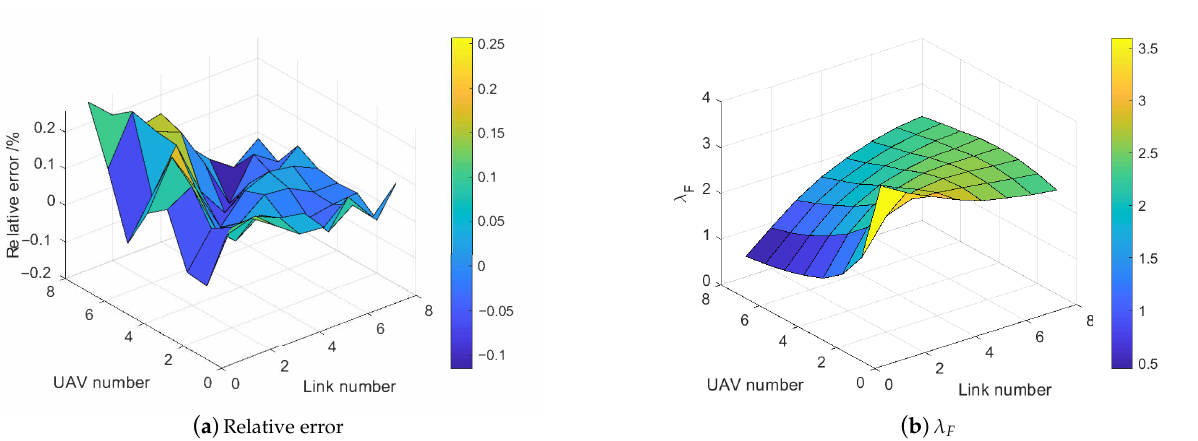
Figure 11. Communication performance surface from the simulated data and the mathematical